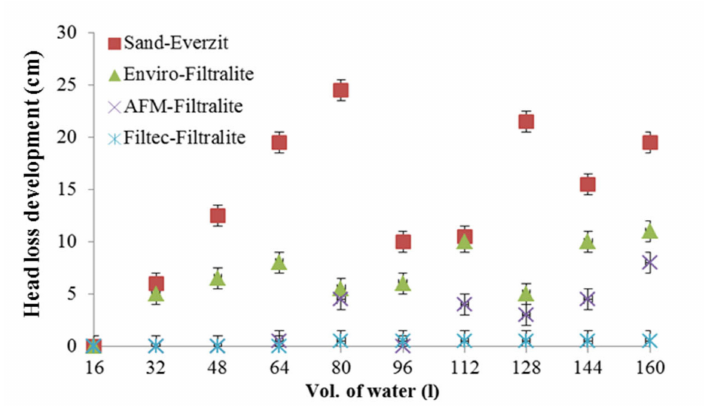
Figure 8. Head loss development in four dual media configurations for the entire run with poly-aluminium chloride as coagulant (reprepared using the data from